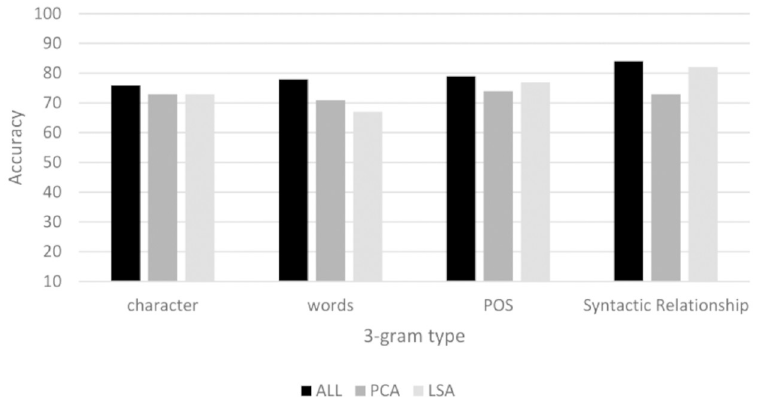
Precision and Recall. Table 13 show the averages obtained in the data. Labels p and r represent precision and recall. It is difficult to observe a pattern due to the 3-gram types. However, the authors GM, LT and MT mostly show values lower than 65%. It should be noted that authors FM and LT show a substantial improvement in syntactic relationships 3-gram. The authors